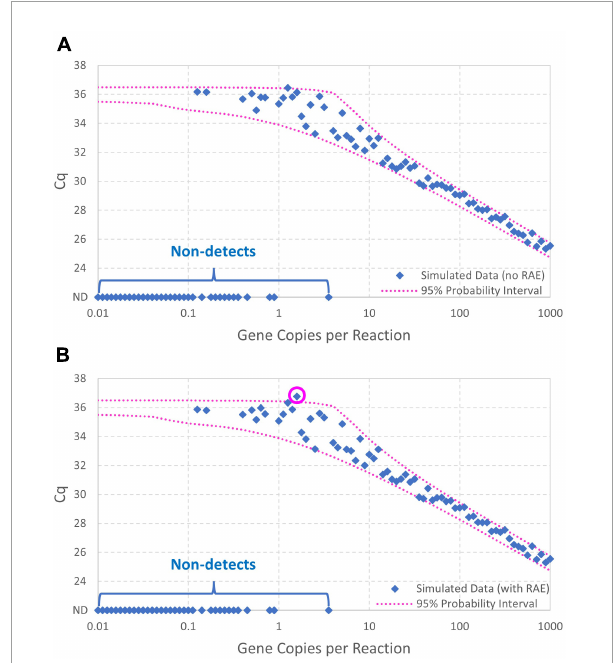
FIGURE5 Data simulated (A) with and (B) without random amplification error (RAE). Data were generated using intercept 36, amplification efficiency E = 0 . 9, and Cq residual standard deviation σ = 0 . 25, and the 95% probability interval was calculated using the same model without including random amplification error. An extreme Cq value highlighting effects of random amplification error is